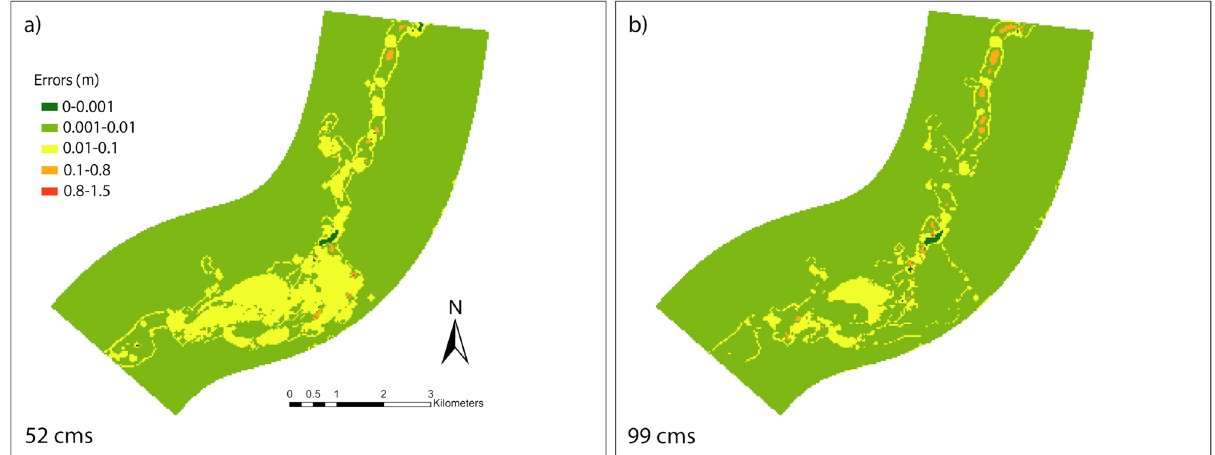
Figure 11. Error distributions calculated by subtracting the water depth from DNN regression model output and iRIC simulation is shown here for two scenarios with upstream discharge of 52 ( a ) and 99 ( b ) cms. Maps are processed and generated in the ArcGIS Pro platform 81